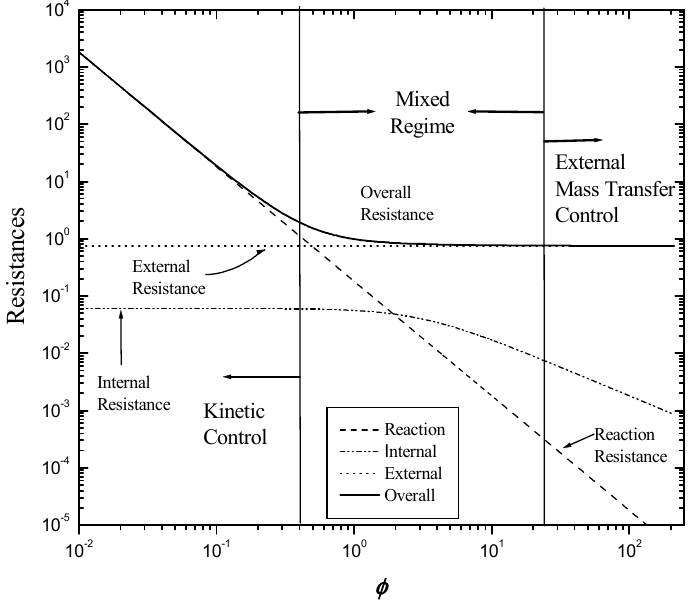
/ D = 13.05 and λ = R / R = f e Ω (cid:3118) Ω (cid:3117)